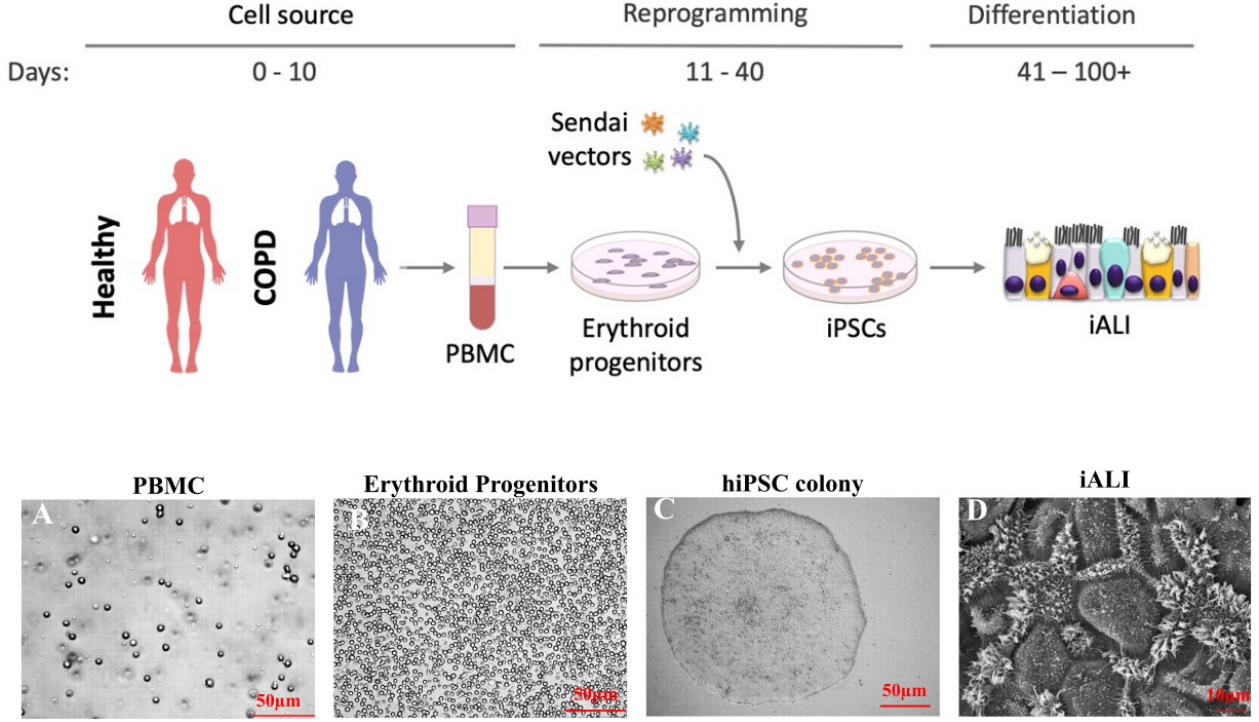
Figure 1. Study protocol: from human induced pluripotent stem cell (hiPSC) generation to hiPSC- derived airway epithelium. Recovery of cell source (day 0 to day 10). Peripheral blood mononuclear cells (PBMC) are isolated from whole blood samples from healthy controls (HY03) and patients with chronic obstructive pulmonary disease (COPD) (COPD 2, 8 and 9). ( A ) Optical microscopy image of PBMCS, scale bar: 50 µm). Then, the CD34+ subpopulation is amplified into erythroid progenitor cells ( B ) optical microscopy image, scale bar: 50 µm). Cell reprogramming (day 11 to day 40). Erythroid progenitors are transduced using Sendai virus-based constructs to express OCT3/4, SOX2, KLF4, and c-Myc. HiPSC colonies are visible at day 40 ( C ) optical microscopy image, scale bar: 50 µm). HiPSC differentiation into airway epithelium (iALI; day 41 to >day 100) ( D ) electronic microscopy image of iALI from the control HY03 hiPSC line, scale bar: 10 µm).